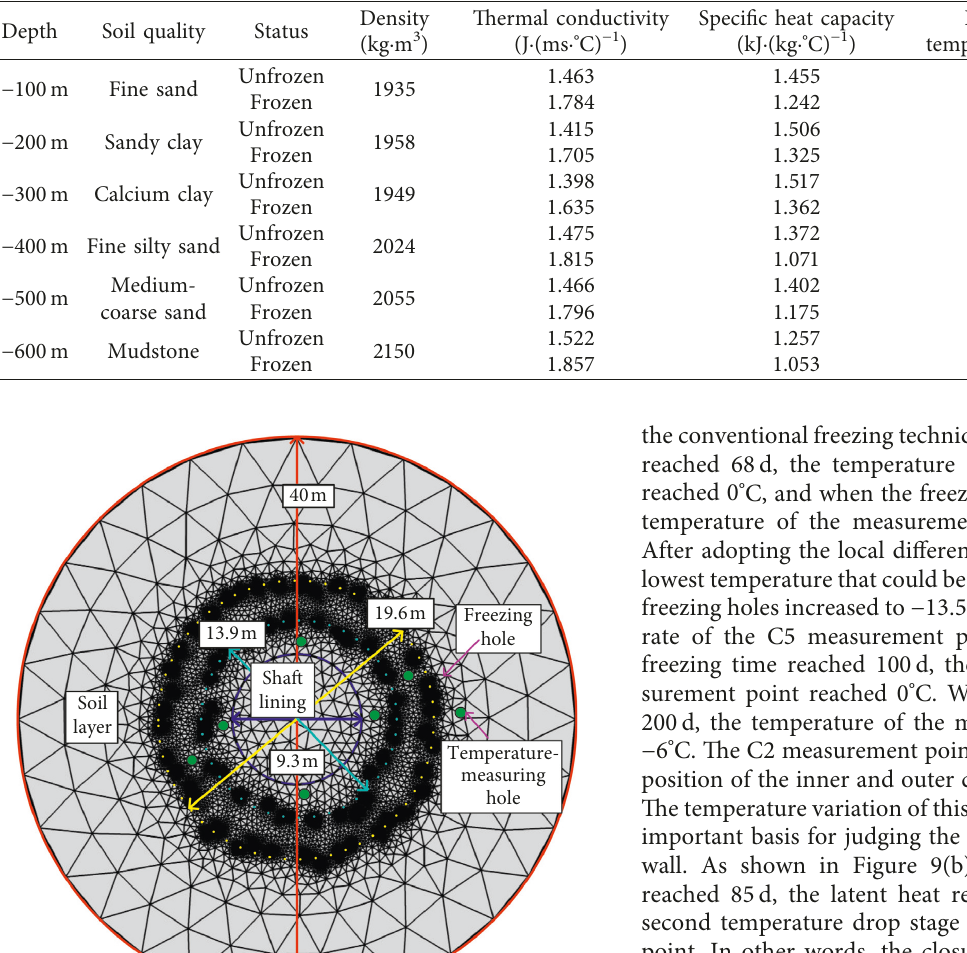
Table 2: Thermophysical parameters of soil layers at various